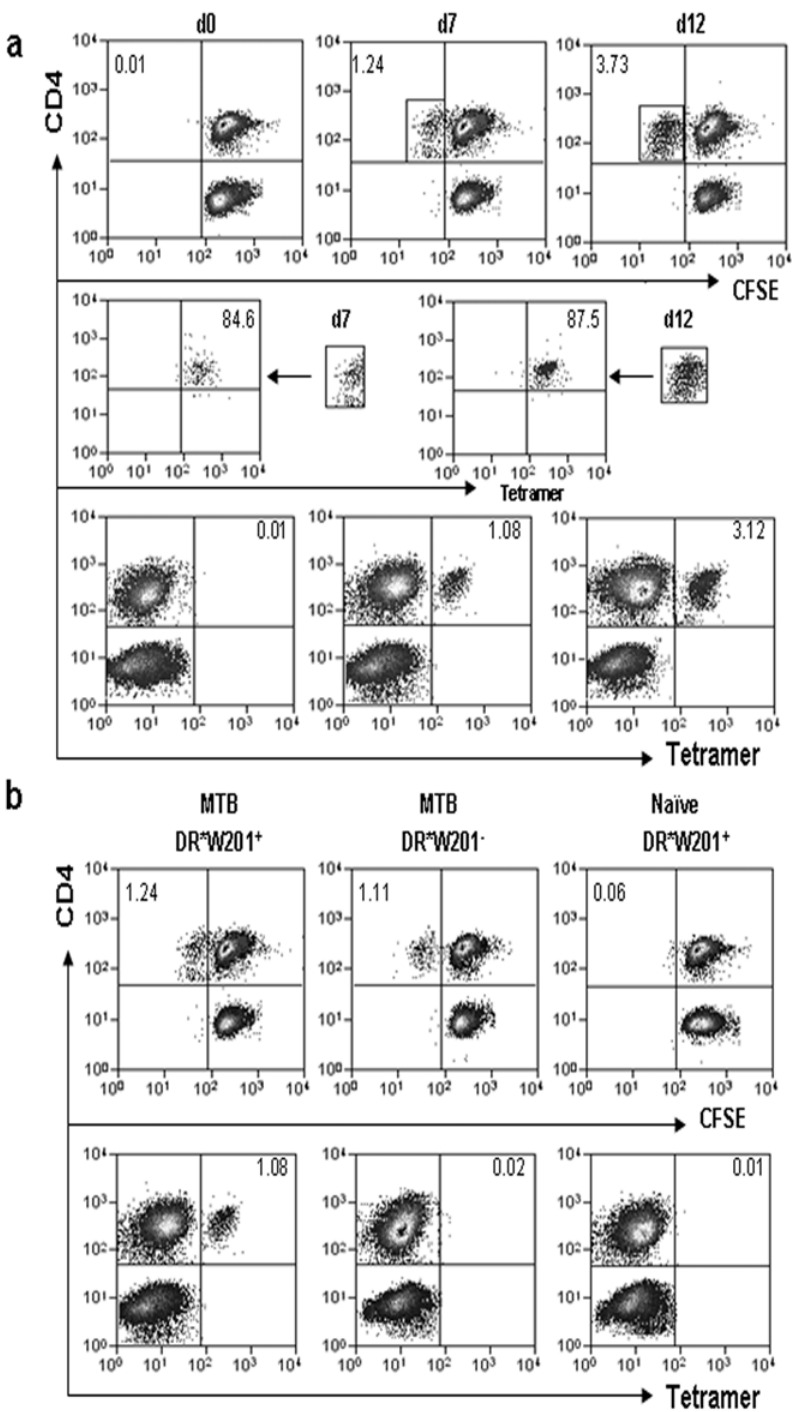
Figure 3. Tetramer was able to specifically stain P65-specific CD4 T cells in M.tuberculosis -infected Mamu-DRB*W201 + macaques. (a) PBL collected at day 42 from the M. tuberculosis -infected Mamu-DRB*W201 + macaque was stimulated with P65 for different days in CFSE-incorporated culture; the proliferating cells were assessed for the ability to be stained by Mamu-DR*W201/P65 tetramer. The upper panel shows CD3-gated flow cytometry histograms indicating proliferating and non-proliferating CD4 T cells as determined by CFSE dilution, with the numbers illustrated as percentages of P65-expanded CD4 T cells. The middle panel histograms indicate that majority of P65-proliferating CD4 cells as gated on CD4 and CFSE could be stained by Mamu-DR*W201/P65 tetramer. The lower panel shows CD3-gated flow histograms indicating the percentages of the tetramer-bound CD4 + T cells in the cultures stimulated with for 7 and 12 days, respectively. The PBL not stimulated with P65 stimulation was denoted as day 0. (b) The CD3-gated flow cytometric data show that Mamu-DR*W201/P65 tetramer specifically stains P65-proliferating CD4 T cells from the M. tuberculosis -infected Mamu-DRB*W201 + macaque but not the naı¨ve macaque or the M. tuberculosis -infected Mamu-DRB*W201 - animal (lower panel).